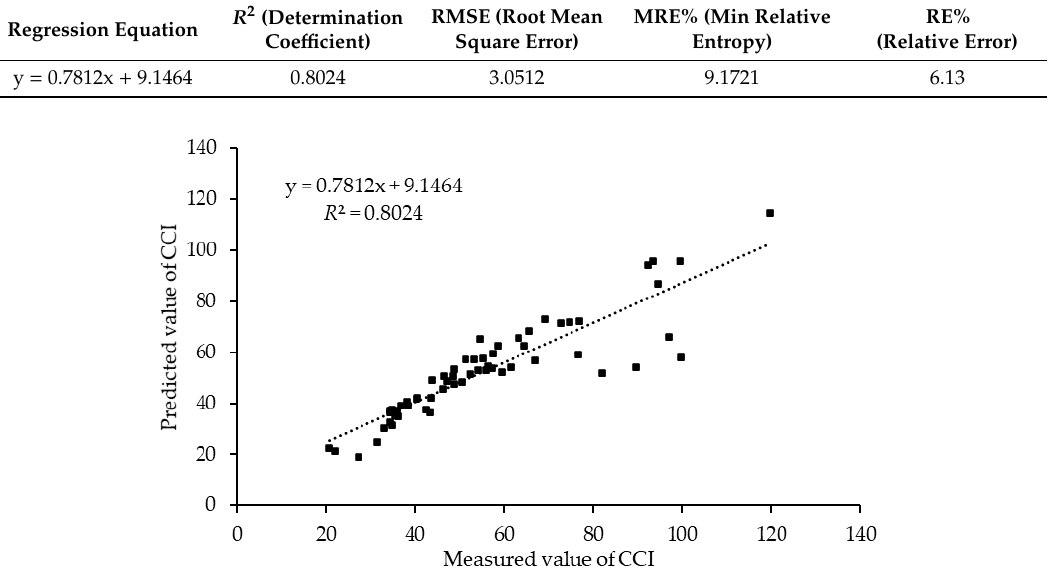
Figure 9. Comparison between the measured value and the predicted value (sample number = 60). CCI (chlorophyll content index).